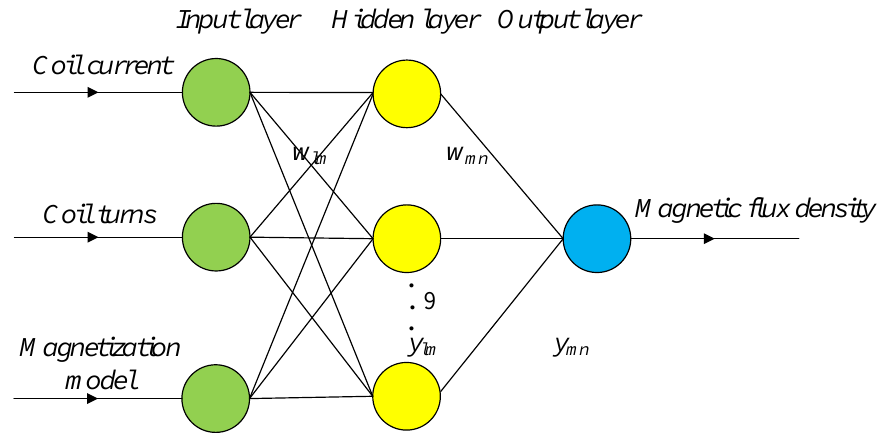
Figure 4. Neural network model structure for magnetic field calculation.